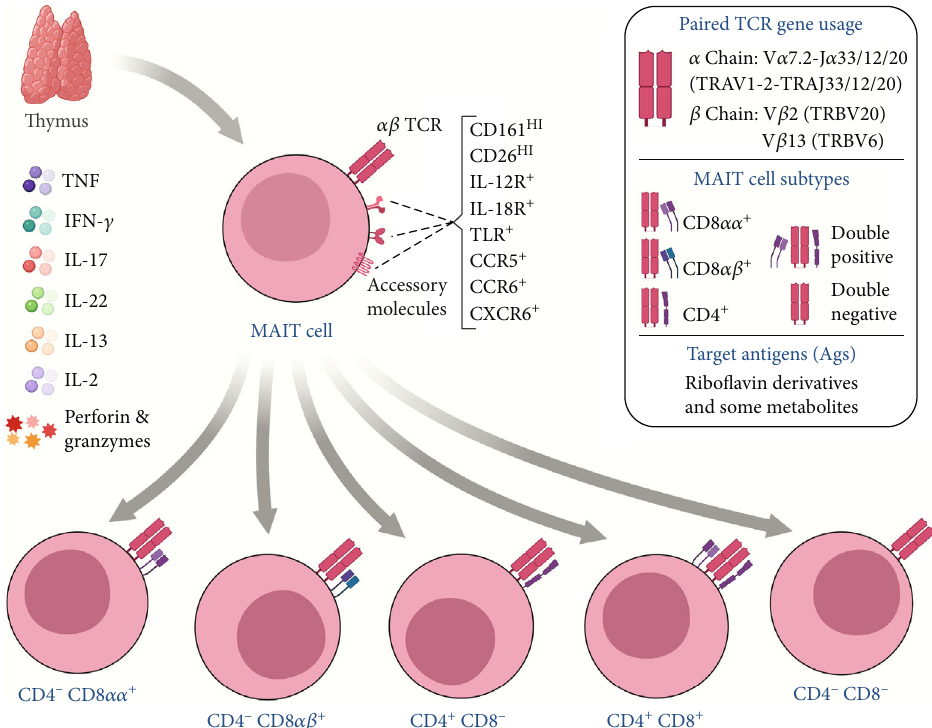
Figure 3: Overview of subpopulations, important receptors, and cytokines produced by MAIT cells. MAIT cells develop in the thymus, where they acquire a semi-invariant TCR, restricted to MR1. In humans, they can be categorized into fi ve subsets based on the expression of the CD4 and CD8 coreceptors, with CD4 - CD8 αα + or CD4 - CD8 αβ + being the most abundant, collectively corresponding to approximately 80% of MAIT cells. They produce a repertoire of Th1 and Th17 cytokines (IFN- γ , TNF, IL-2, IL-17A, and IL-22), in addition to perforins and granzymes B, and express various cytokine, chemokine, and homing